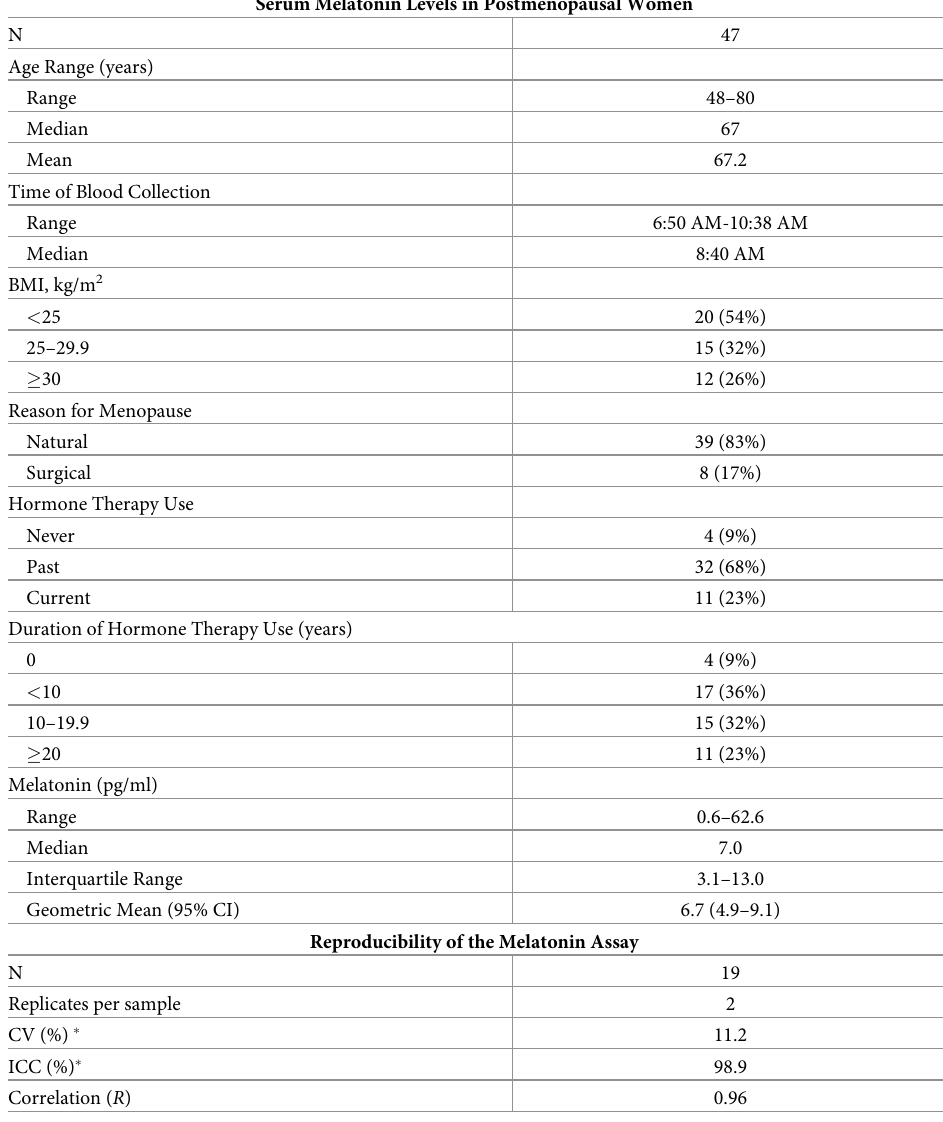
Table 1. Range of morning melatonin levels and reproducibility of serum melatonin assays in postmenopausal non-Hispanic white women.